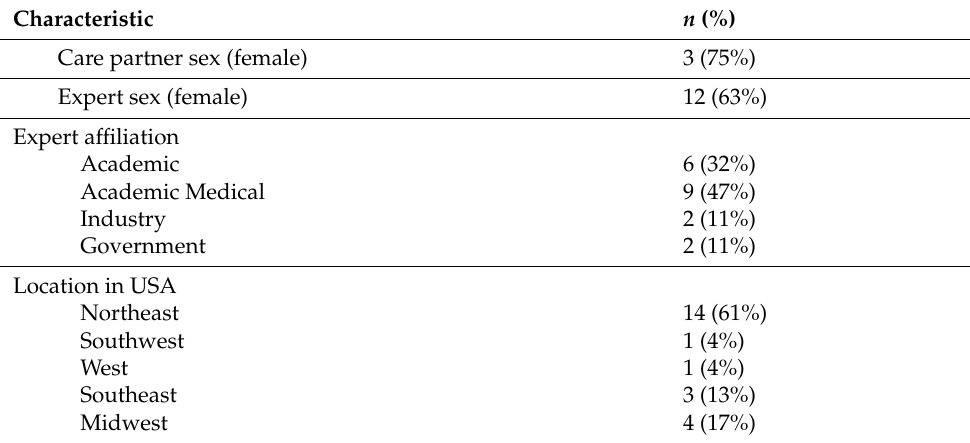
Table 1. Demographic characteristics of participants.